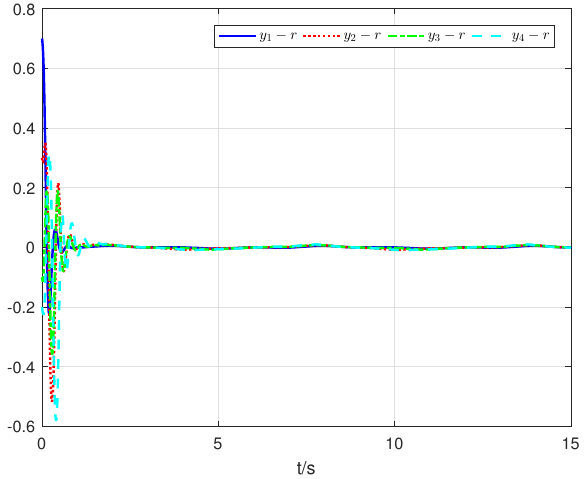
Figure 4. The trajectories of the consensus tracking errors y i − r .